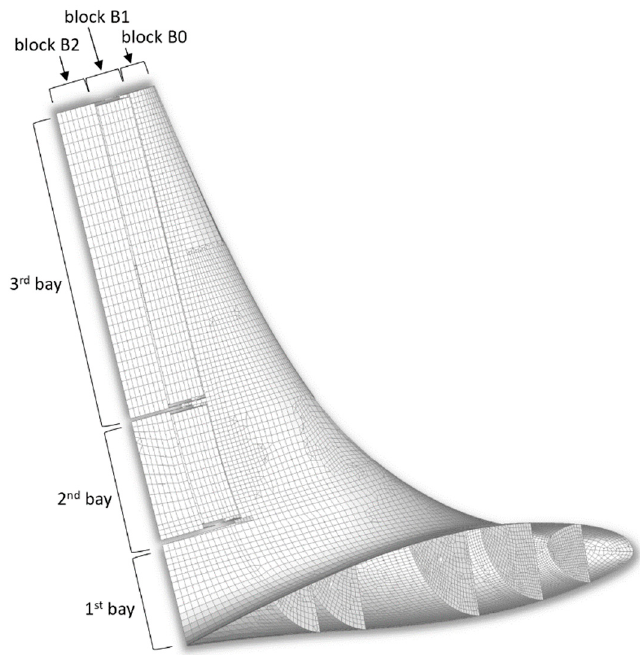
Figure 11. Left hand side (LH) morphing winglet preliminary finite element model.